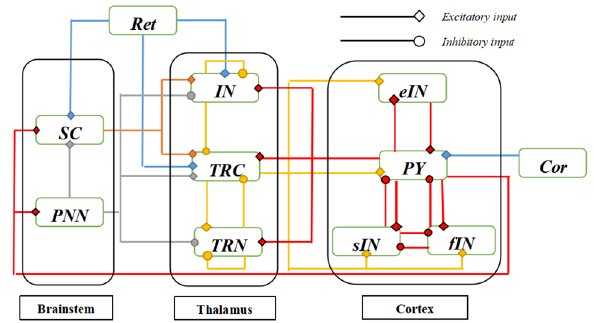
Figure 1. The layout for module structure and synaptic connectivity in the BTC model. The BTC model comprises of three formations: brainstem module, thalamus module and cortex module. In the brainstem module there are two populations of superior colliculus (SC) and pedunculopontine nucleus (PNN). In the thalamus module there are thalamic relay nucleus (TRC), inhibitory interneurons (IN) and thalamic reticular nucleus (TRN). In the cortex module there are pyramidal neurons(PY), excitatory interneurons (eIN), fast inhibitory interneurons (fIN) and slow inhibitory interneurons (sIN). Ret and Cor denote external visual inputs and adjacent cortical inputs respectively. Diamond represents excitatory inputs and circle represents inhibitory